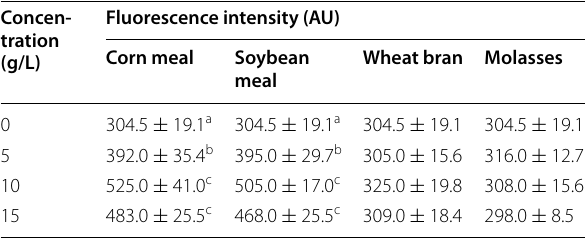
Mean values in the same column with different letters (a, b, c) are significantly different ( P < 0.05). The final results are expressed as the mean deviation (n 3) of 1000-fold diluted spore samples =